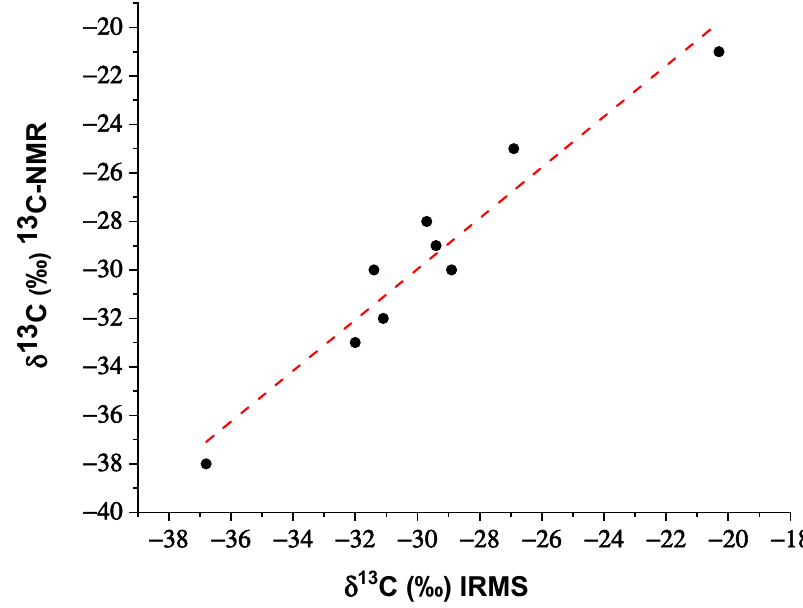
Figure 4. Correlation plot between δ 13 C values (‰) obtained with IRMS and 13 C-NMR.